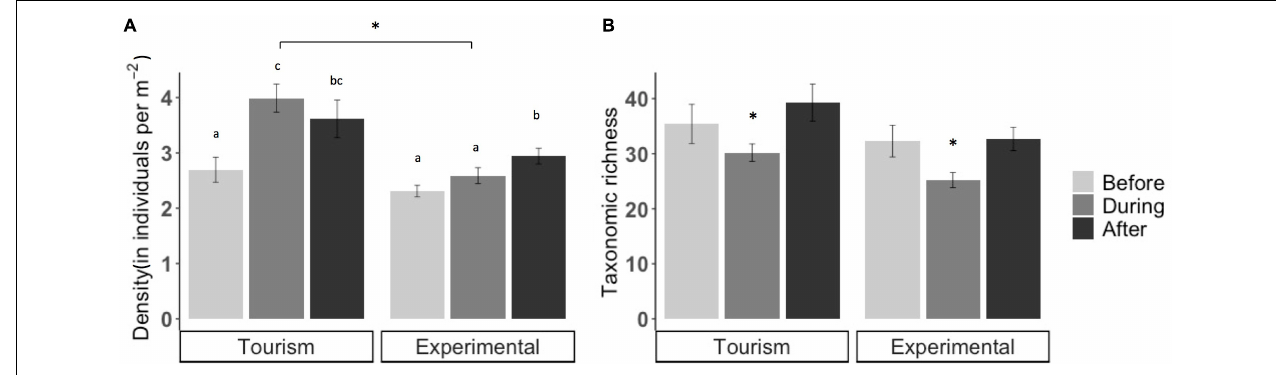
FIGURE 2 | Mean (A) fish density ( ± SE) (B) and taxonomic richness ( ± SE) before, during, and after artificial feeding events at tourism and experimental feeding sites. Note that the scale of y axes differs and significant differences are indicated by asterisks and letters.